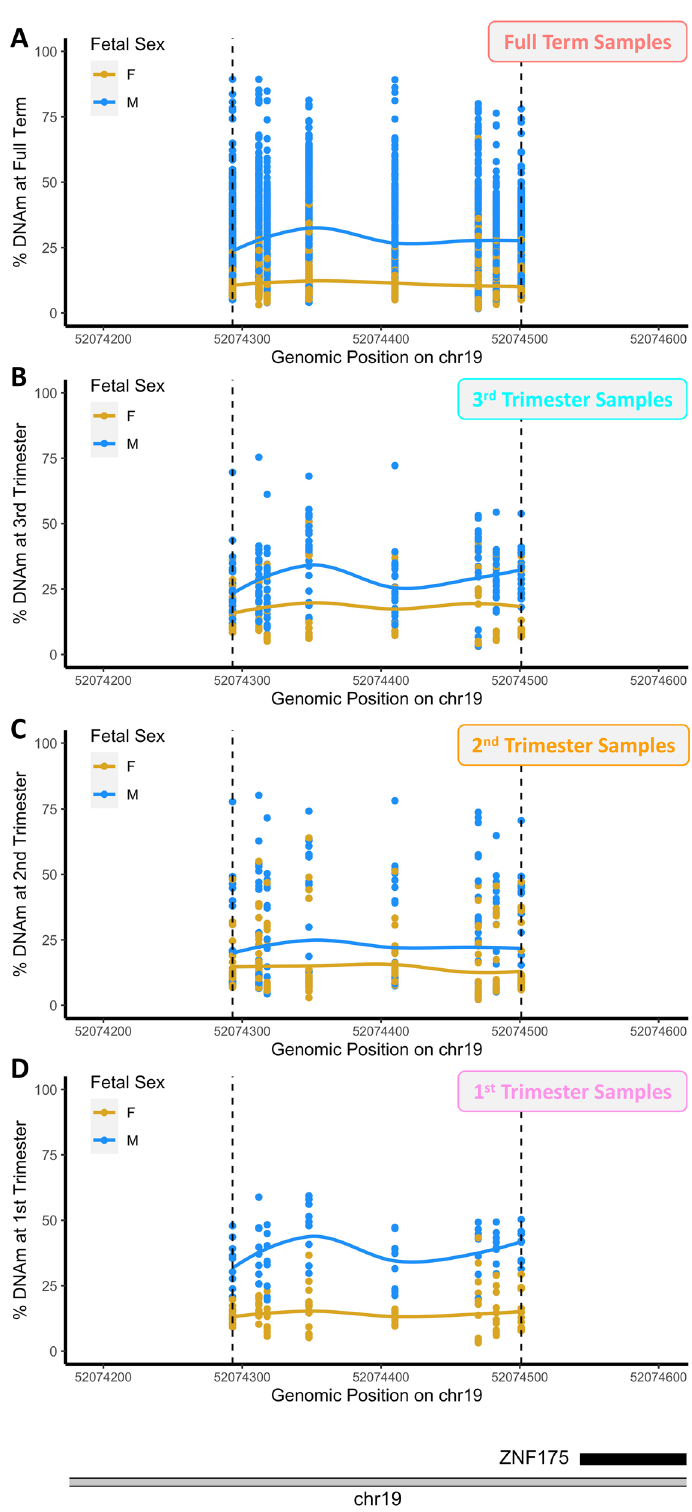
Figure 4. DMR at the ZNF175 promoter across the gestational period. Top-ranked DMR from full term analysis at ZNF175 promoter. DMRs are plotted as percent methylation as a function of genomic position. Dots indicate samples and solid lines indicate smooth lines through male sample values (blue) and female sample values (gold). Actual identified DMR region indicated via dashed lines. ( A ) Full Term Samples. ( B ) 3rd Trimester Samples ( C ) 2nd Trimester Samples ( D ) 1st Trimester